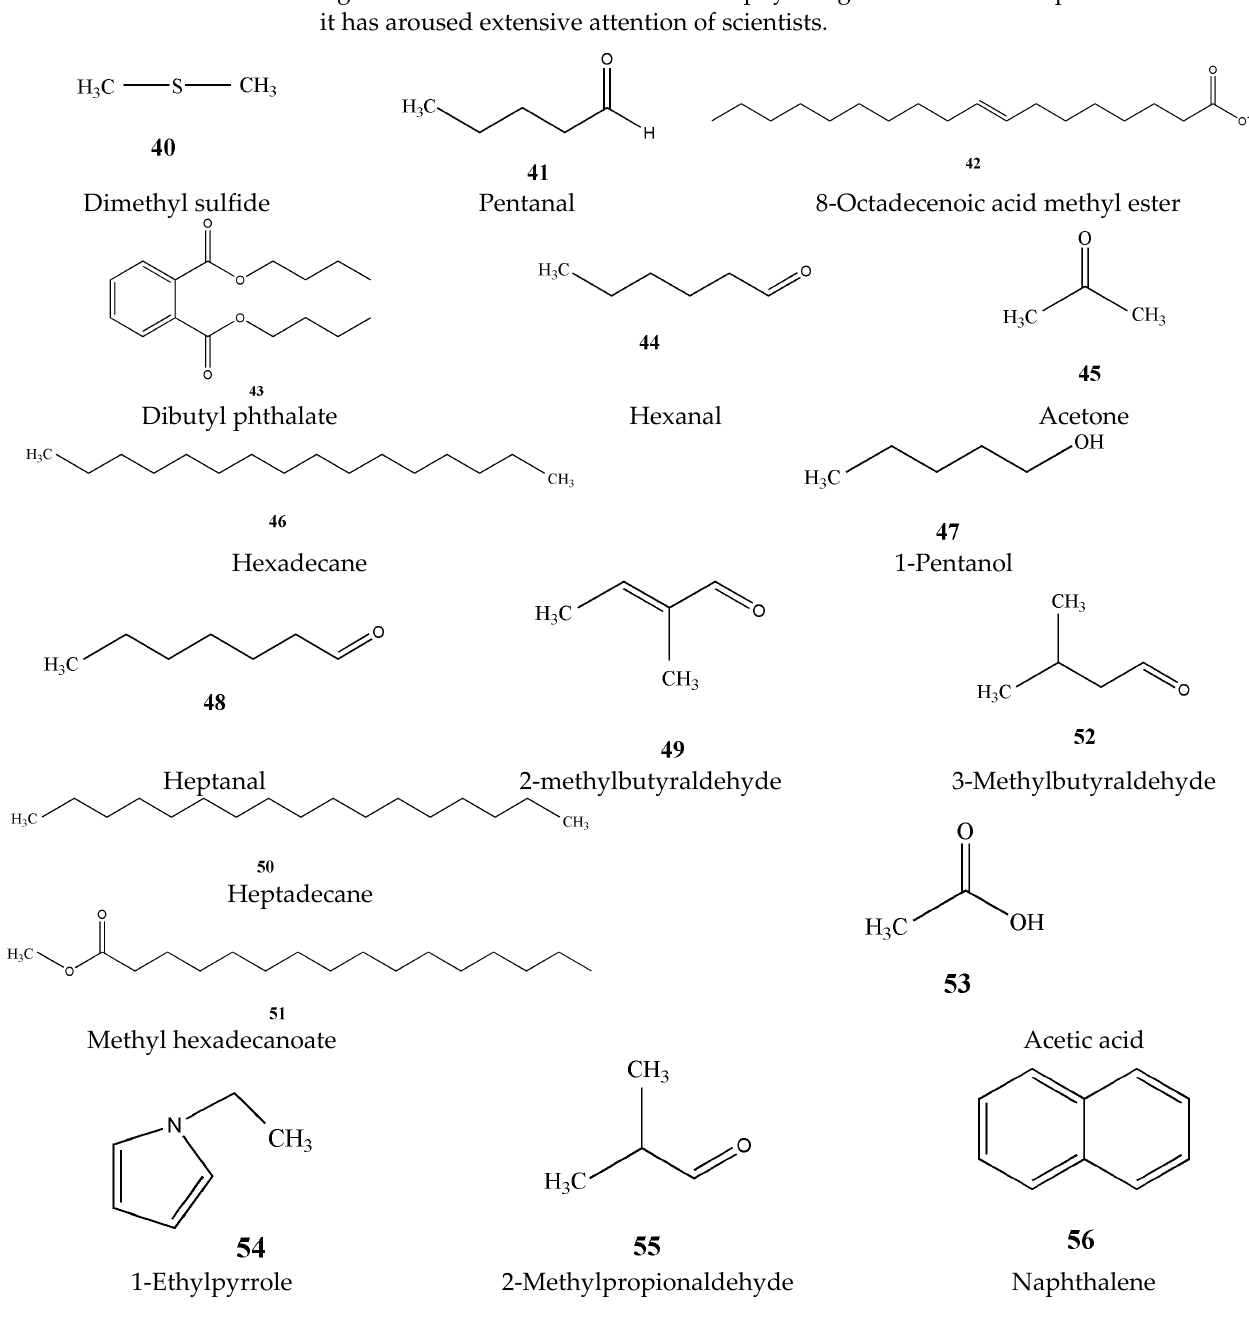
Figure 7. Chemical structures of aromatic ingredients isolated from green tea.